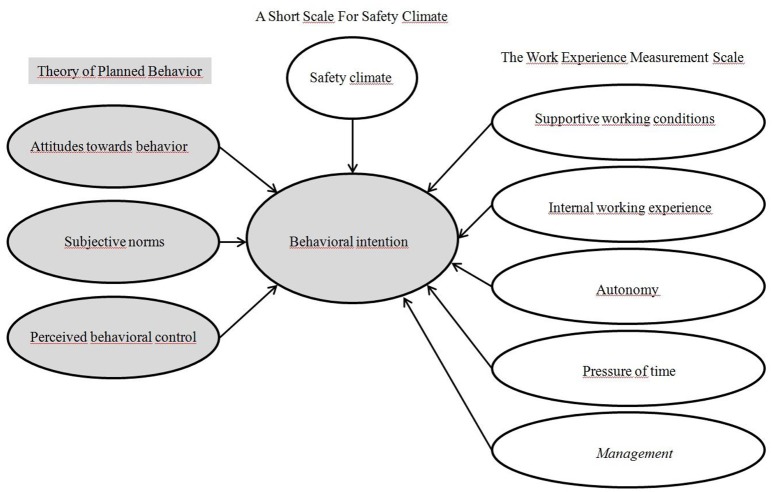
Visual representation of the conceptual model that will be used in the SEM analysis. The Theory of Planned Behavior components are marked with a gray background.